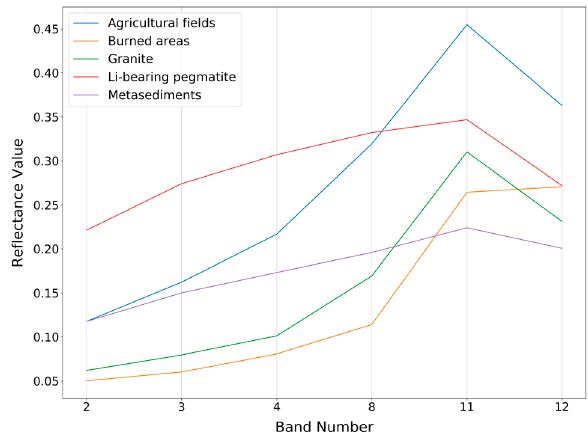
Figure 3. Mean spectral signatures based on the training pixels selected for each class.